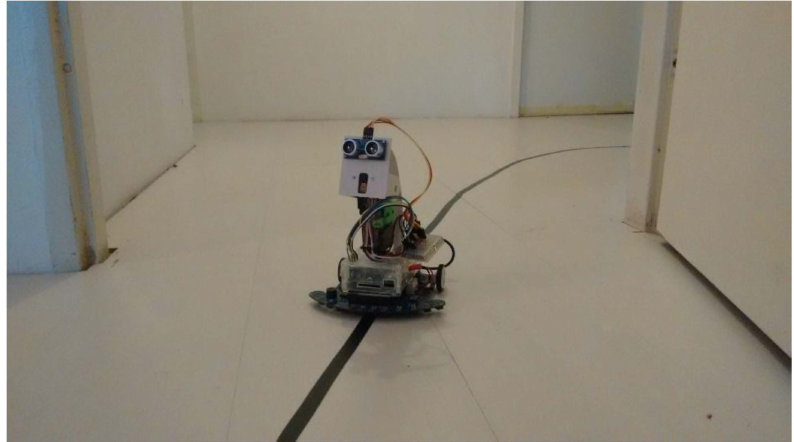
Figure 13. Our low-cost robot controlled by our human-hand gesture